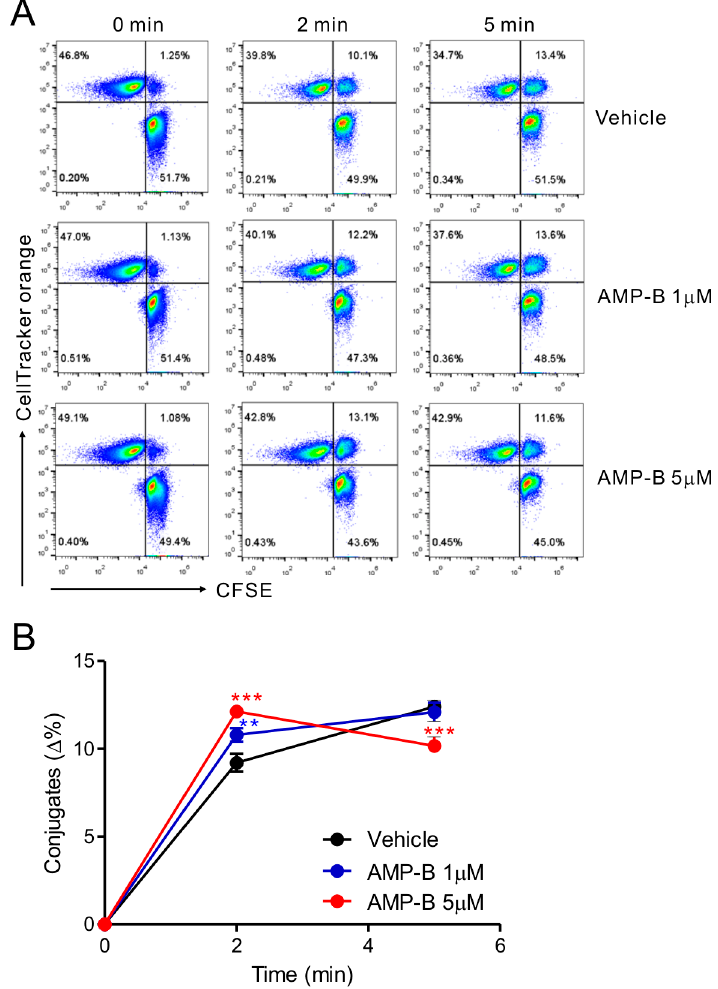
Figure 3. AMP-B increased conjugate formation in NK-target cells. NKL cells loaded with CFSE were treated with the indicated doses of AMP-B for 30 min and then incubated with CellTracker orange CMTMR-labeled 221 target cells at an E: T ratio of 1:1 for the indicated time points. Cells were then fixed and analyzed by flow cytometry to detect conjugate formation, as represented by the double-positive population in the upper right quadrant. Shown are representative flow cytometry profiles of two independent experiments ( A ) and summary graphs of statistical line charts ( B ) showing conjugate formation between NKL cells and 221 cells. ** p < 0.01 and *** p < 0.001.